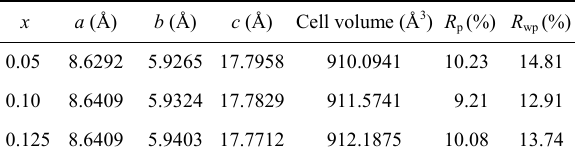
Fig. 2 Refined XRD patterns of Li 3 Mg 2 Sb 0.9 O 6 ceramics under different sintering temperatures. Table 1 Refinement parameters and reliability factors of Li 3 Mg 2 Sb 1– x O 6 ceramics sintered at 1250 ℃ for 5 h